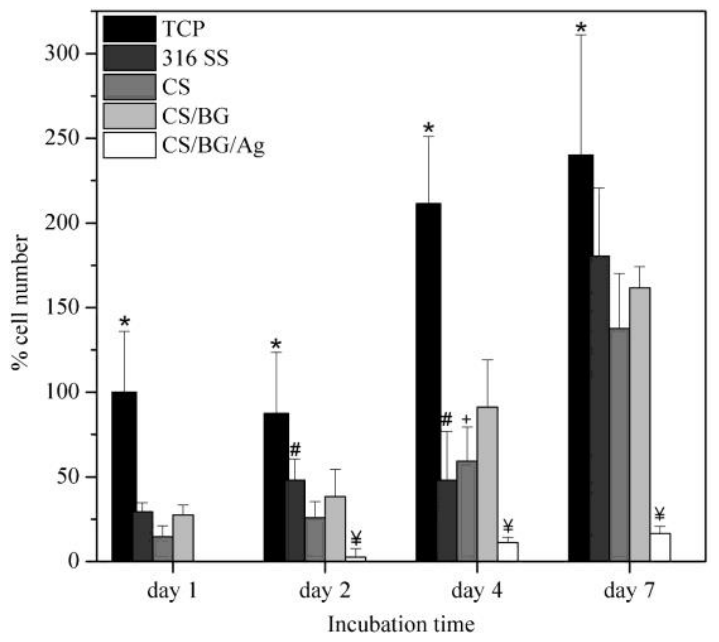
Figure 9. Effect of coating SS-316 (stainless steel-316) with CS (chitosan), CS/BG (Chitosan/Bioglass), and CS/BG/Ag (Chitosan/Bioglass/silver nanoparticles) on MG-63 cell viability measured over seven days by alamarBlue (R) assay. Data represent mean ± SD of two individual experiments each performed in quadruplicate. ( p < 0.05 at the same time period: * is for TCP vs. all other coatings; ¥ is for CS/BG/Ag vs. all other coatings; # is for marked bar vs. CS; + is for marked bar vs. CS/BG) (adapted with permission from reference [18]).